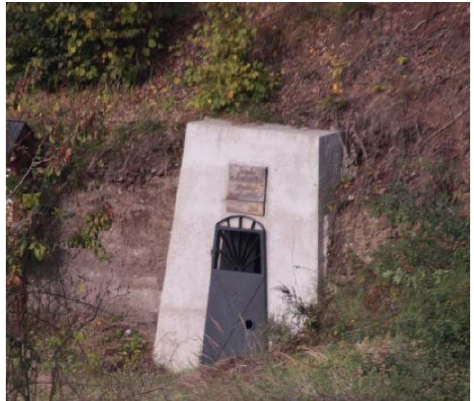
Figure 6. Technical mining equipment, Porá č (photo of the authors).